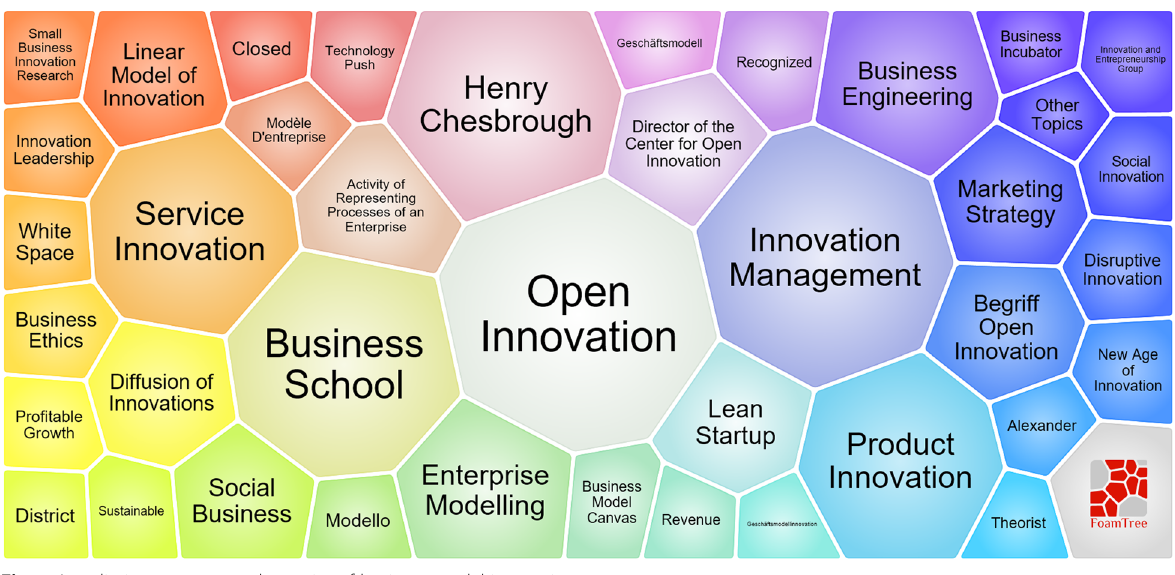
Fig. 1 A preliminary survey on the topics of business model